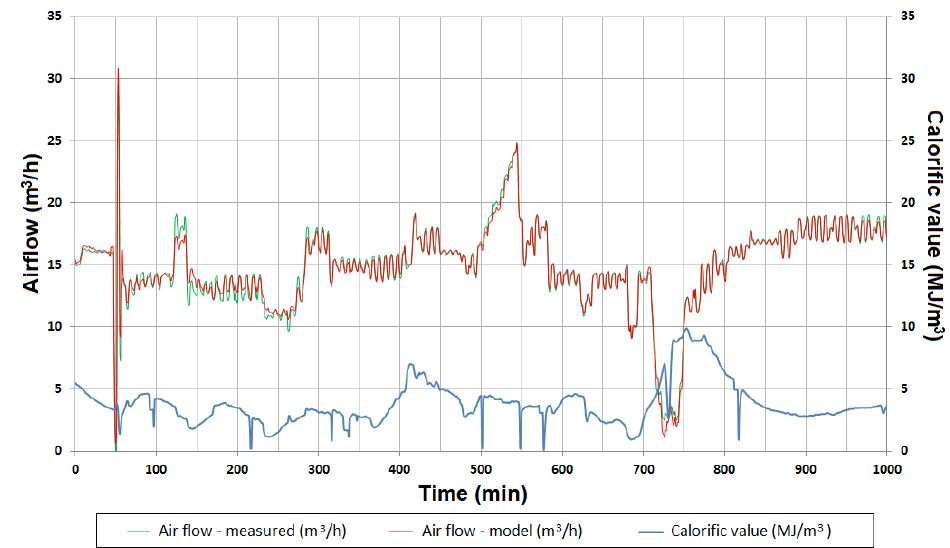
Figure 20. Simulated and measured oxygen flow [25].